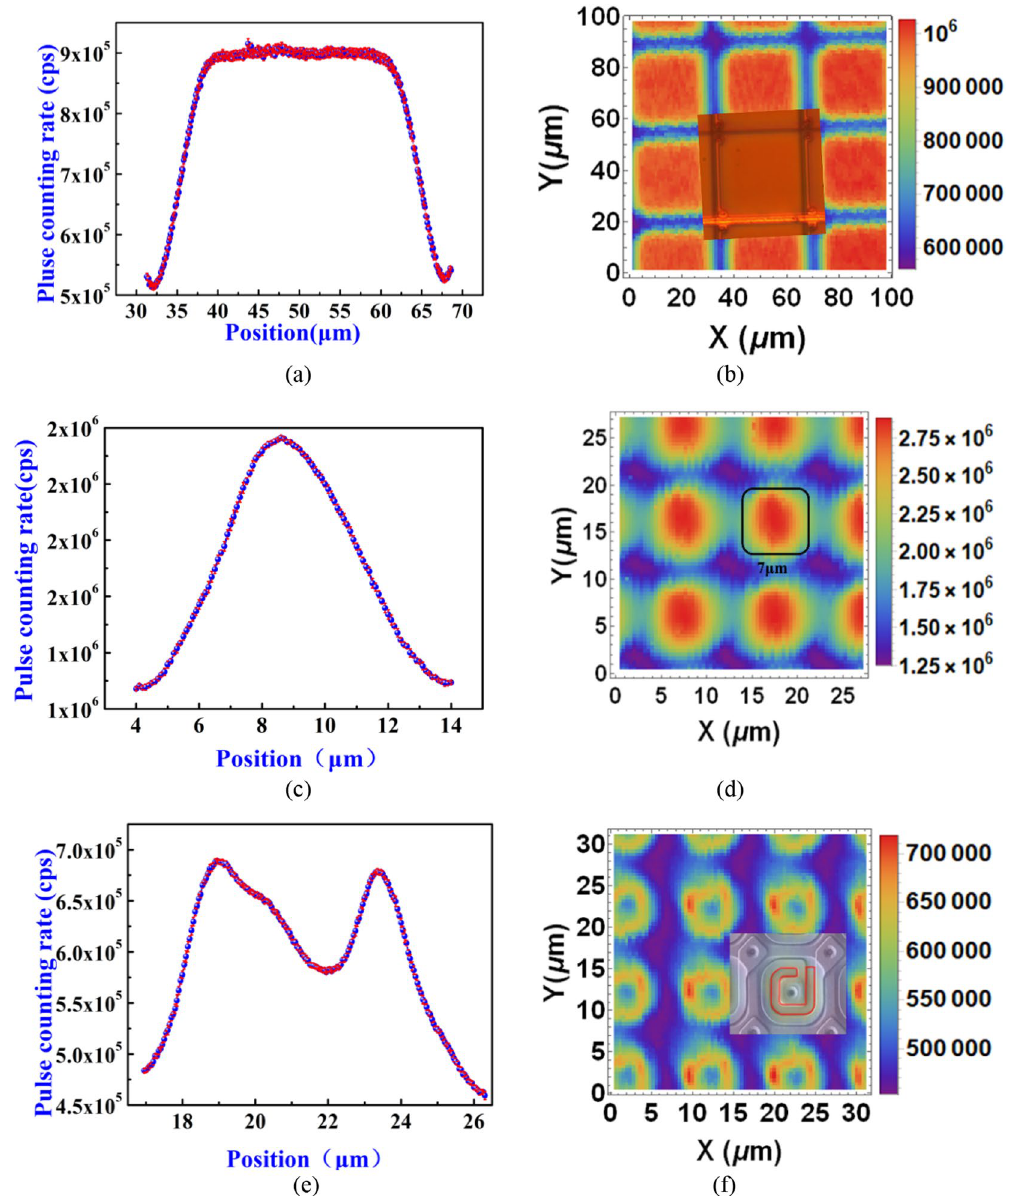
Figure 3. Spatial 1D and 2D distributions of the relative photoresponse (i.e. PCR , recorded at 0.5 p.e. threshold) of SiPMs to the single-photon-level light focal spot. ( a ) 1D and ( b ) 2D distribution of the PCR of the SiPM from Fondazione Bruno Kessler (FBK), Italy (model = NUV-HD-LF), with 35 μm Gm-APD cell pitch(The inset is the optical microscope photograph of the SiPM surface); ( c ) 1D and ( d ) 2D distribution of the PCR of the SiPM from novel device laboratory (NDL),China (model = EQR1011-1010C-T), with 10 μm Gm-APD cell pitch(the black solid square with rounded corners is the layout of the active region 29 ); ( e ) 1D and ( f ) 2D distribution of the PCR of the Hamamatsu SiPM, Japan (model = S12571-010C) with 10 μm Gm-APD cell pitch(The inset is the secondary electron microscopy (SEM) image of the SiPM surface 18 ). (( a , c , e ) is corresponding to the function h ( x , y ) in Eq.